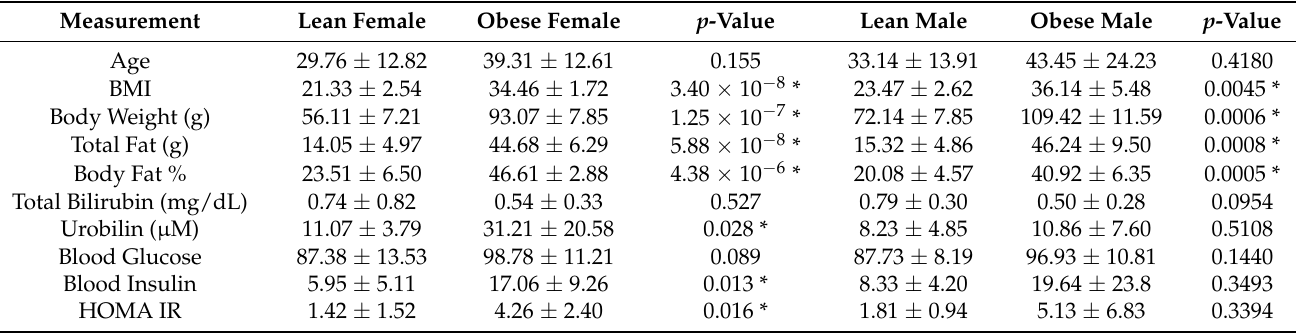
Table 2. Phenotyping of obese and lean men and